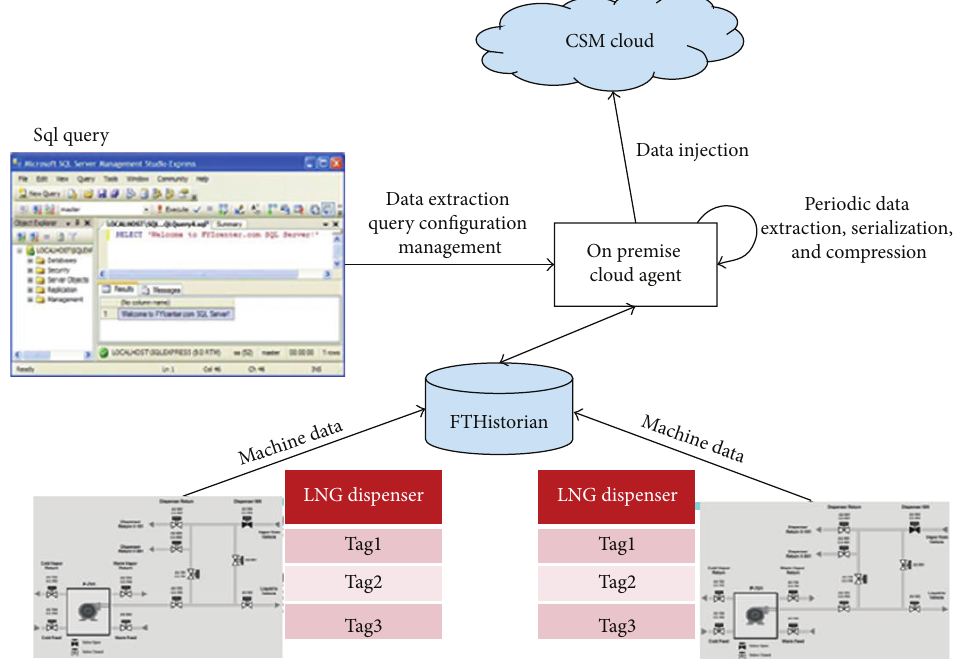
Figure 6: On-premise architecture.